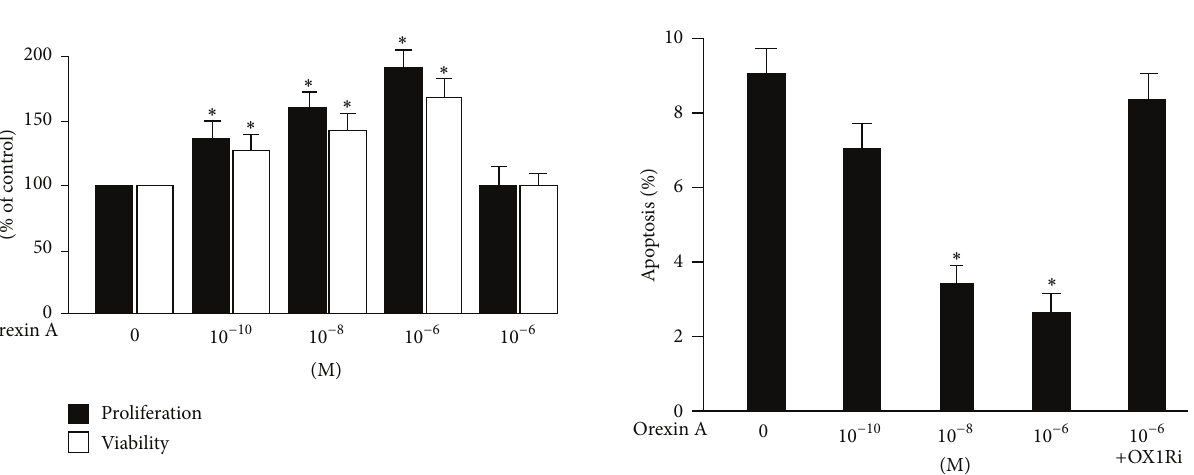
likely occurring via the AKT signaling